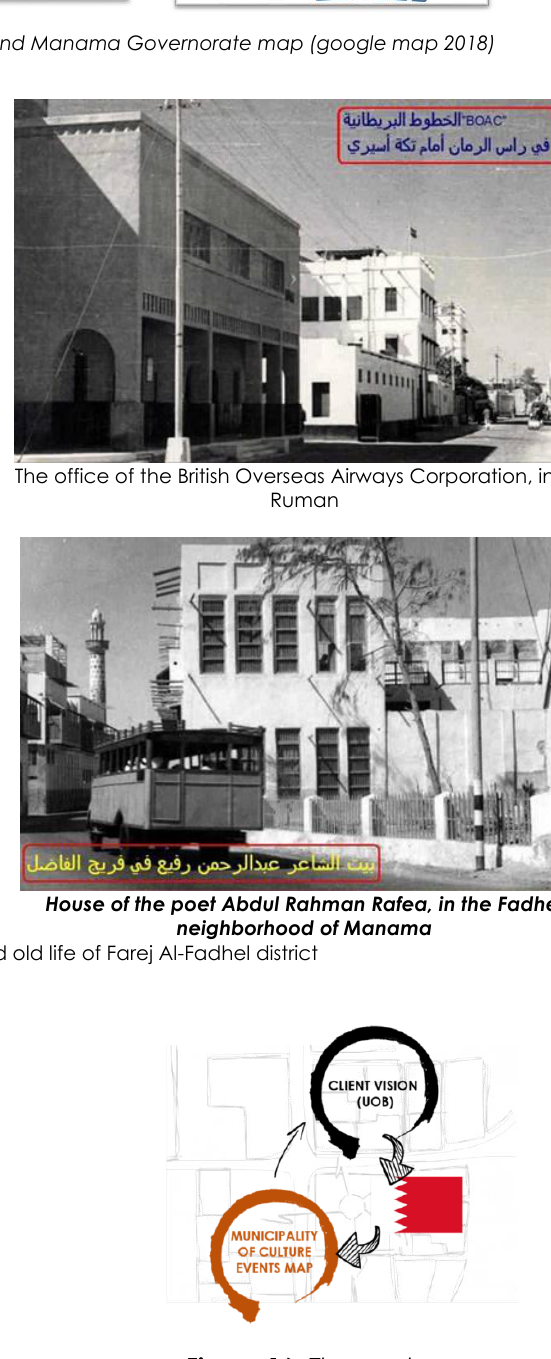
Figure 16. The anchor, source: